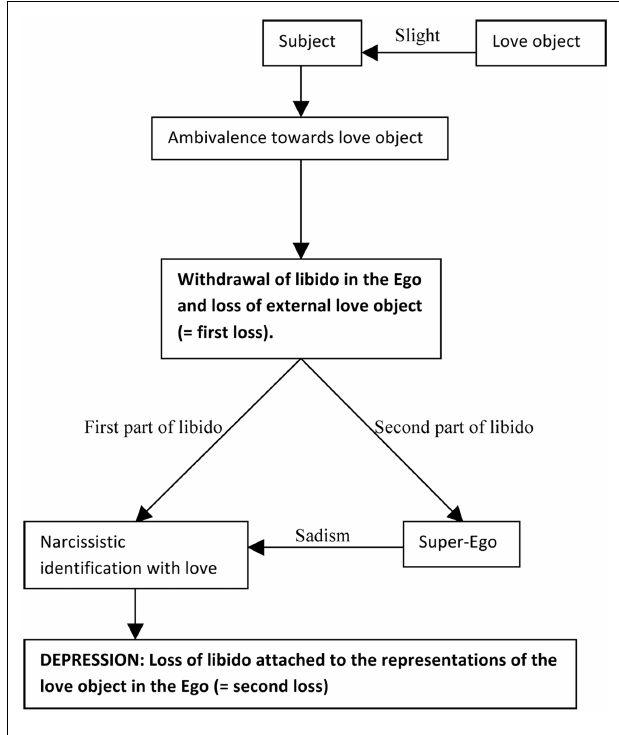
FIGURE 1 |The intra- and interpersonal loss in the etiology of depression according to the theory of Freud in Mourning and